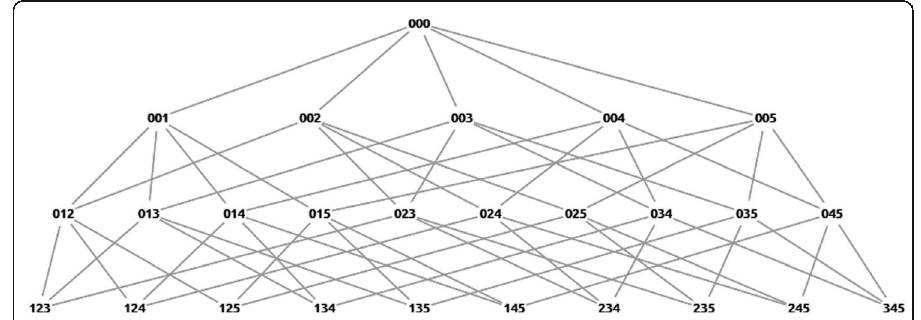
Fig. 4 Problem state spaces of a combination story problem with five available sentence